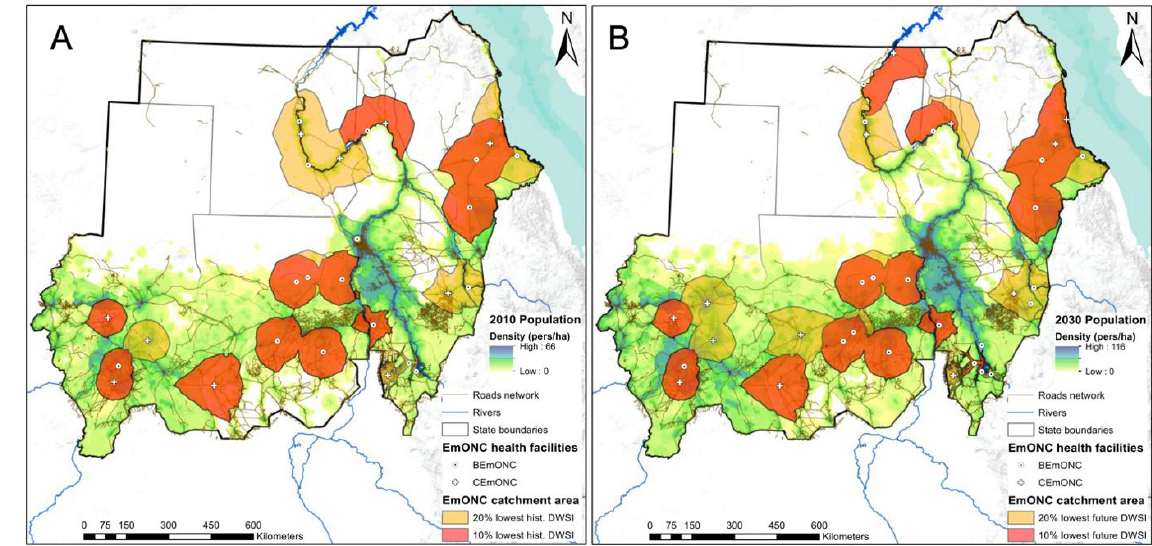
Figure 8. Historical ( A ) and future ( B ) catchment area of the EmONC facilities that are among the 20% and 10% of health facilities with the lowest DWSI.